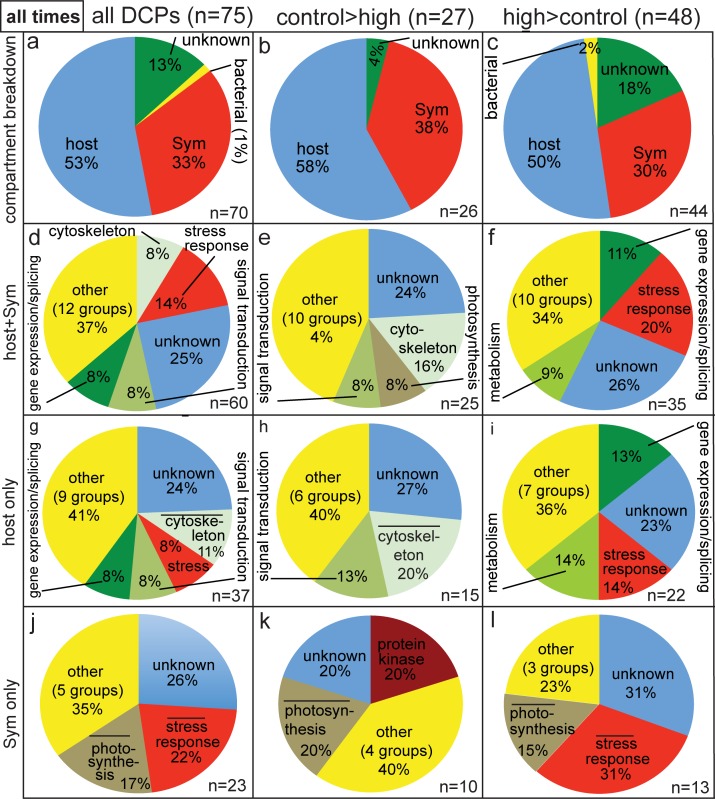
Compartmental and functional breakdown of all differentially concentrated proteins (DCPs).Across the nine, eight, and eight differentially concentrated/uniquely synthesized protein spots removed from representative gels of the two-, four-, and eight-week sampling times, respectively, 75 DCPs were uncovered; upon counting five proteins sequenced at multiple time points only once, 37 and 23 of the 70 unique DCPs were found to be of host coral (Pocillopora acuta) and Symbiodinium (Sym) origin, respectively. When a cellular process was over-represented in the differentially concentrated proteomes of the host coral (g-i) and Sym (j-l) relative to the host coral and Sym transcriptomes [29], respectively (2-sample proportion test, p<0.05), a bar has been inserted above the category name.